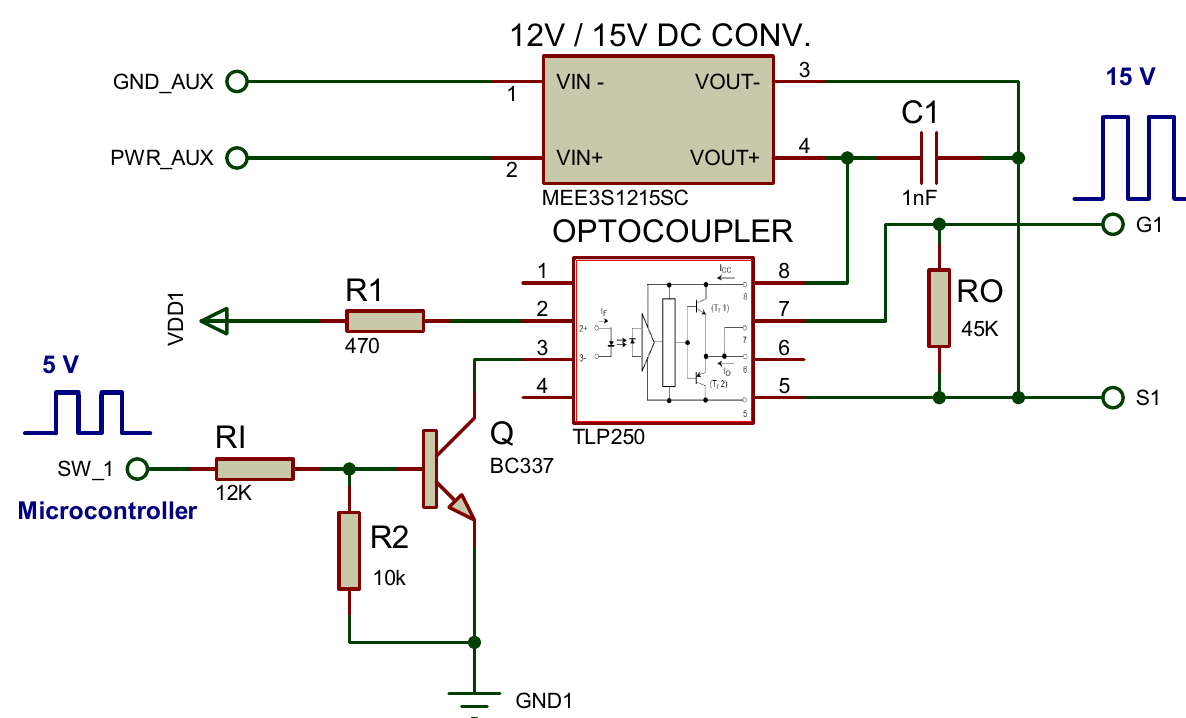
Figure 17. Switches optocoupler isolation driving circuits, TLP250 opto-coupler. 12V / 15V DC